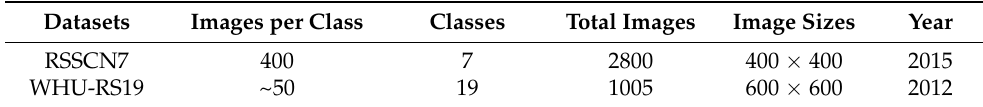
Table 1. The main characteristics of the applied